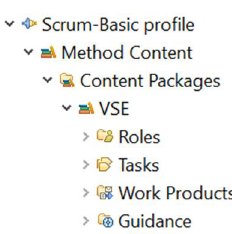
Figure 6. Prepared elements for the method content input in EPF Composer.